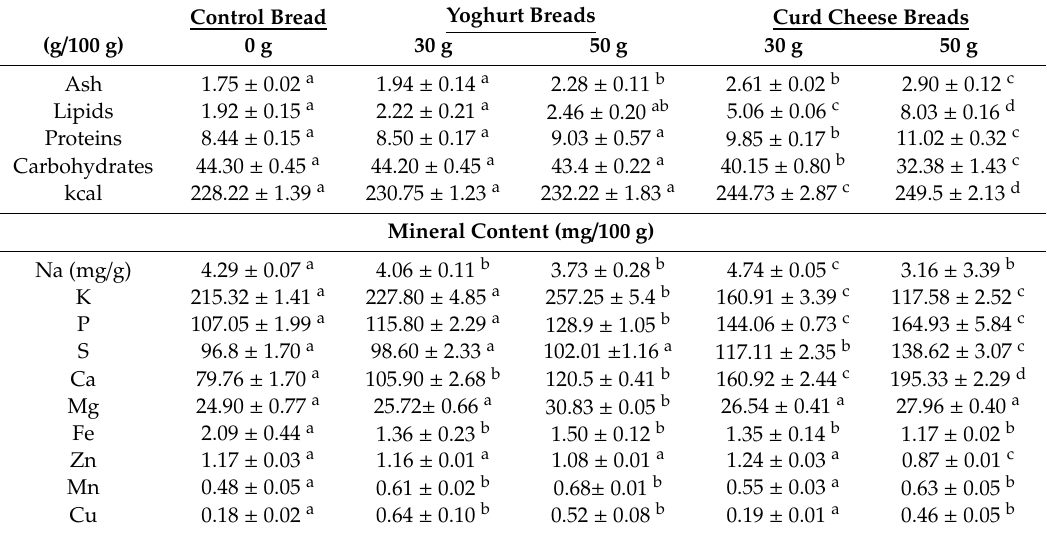
Table 4. Nutritional composition * and mineral content of breads produced with yoghurt and